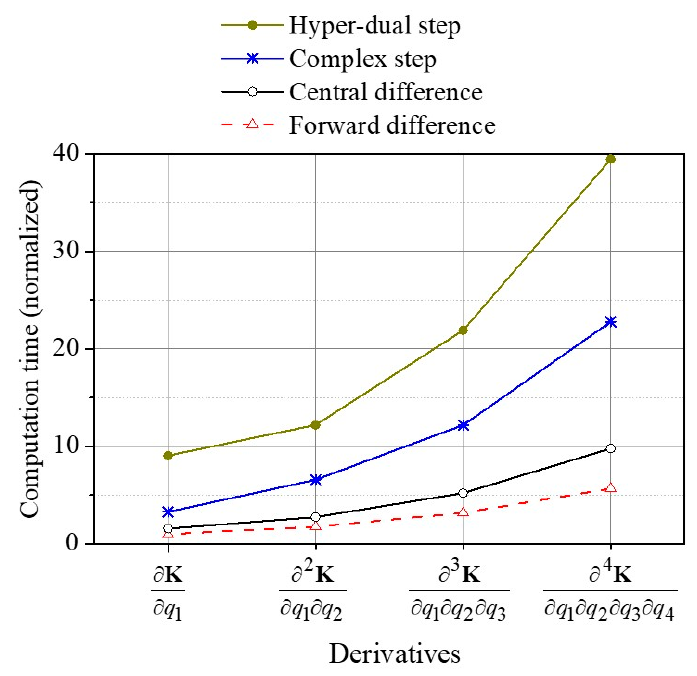
Figure 13. Computation cost of numerical methods.